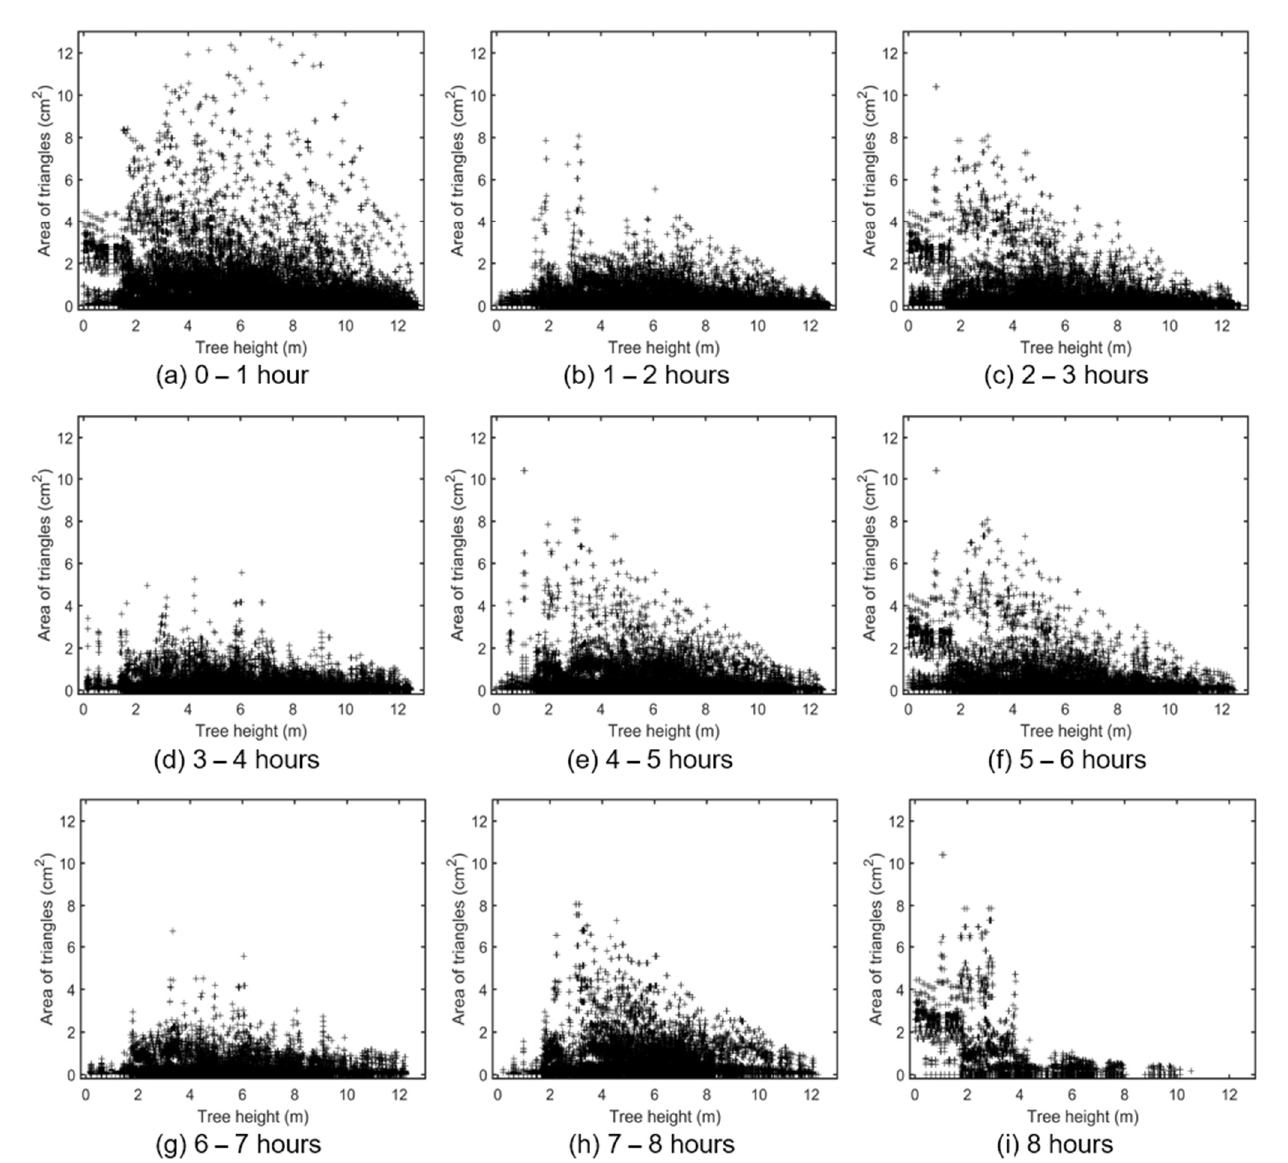
Figure 7. The distribution of the area of faces (triangles) in tree height classified by sunlight duration. ( a – h ): Daylight duration from 0–1 h to 7–8 h; ( i ) 8 h, full exposure under the sunlight. Table 3. Statistical table of daylight duration classified by hours.